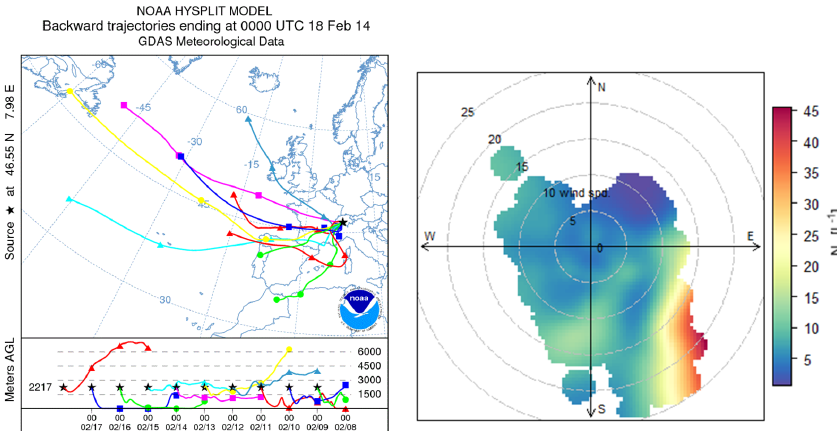
Figure 2. Left panel: HYSPLIT back trajectories for the period 8–18 February. Right panel: fluorescent aerosol concentration (L − 1 ) depen- dence on wind speed and direction. Wind speed denoted by concentric rings (5ms − 1 per ring).